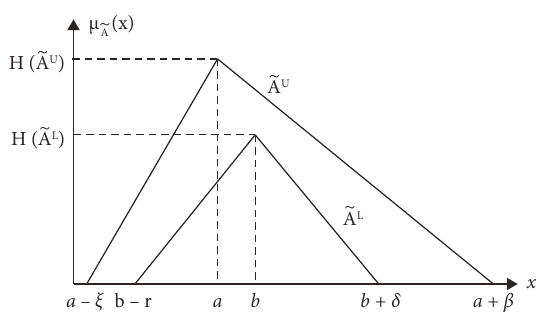
Figure 2: A triangular interval type-2 fuzzy